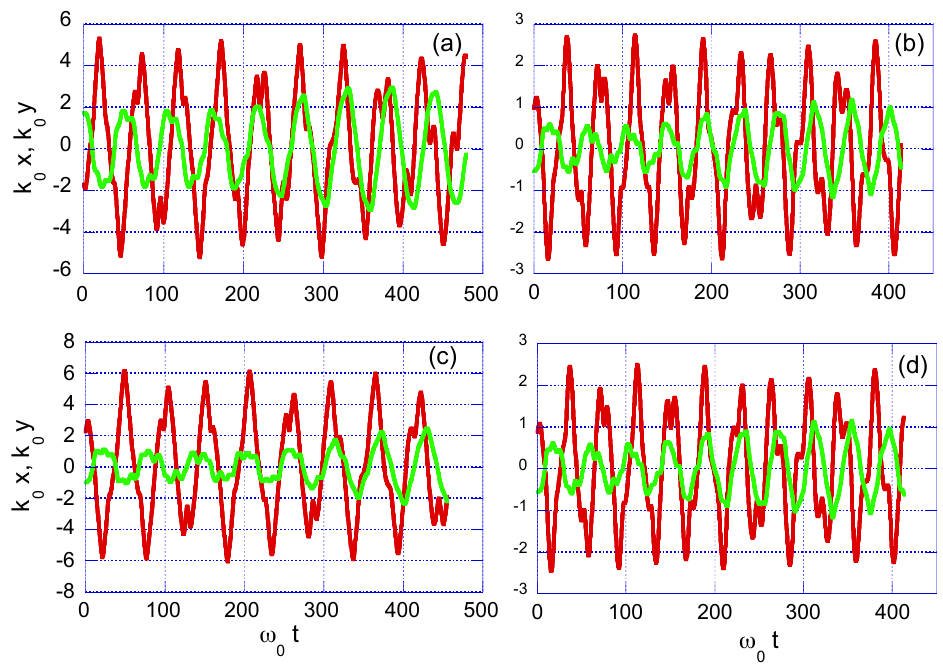
Figure 6. Temporal evolution of normalized x ( t ) (in red) and y ( t ) (in green). Abcissas and ordinates are dimensionless, being respectively the products ω 0 × t and k 0 × x ( t ) = 2 π x ( t ) / λ 0 , etc. Four cases with different initial conditions are displayed, see main text for further details. Trapped solutions are apparent as confined motions in the transverse x − y plane. The characteristic frequencies of these trapped solutions are much higher than in case-study 1 and they have a more complex temporal